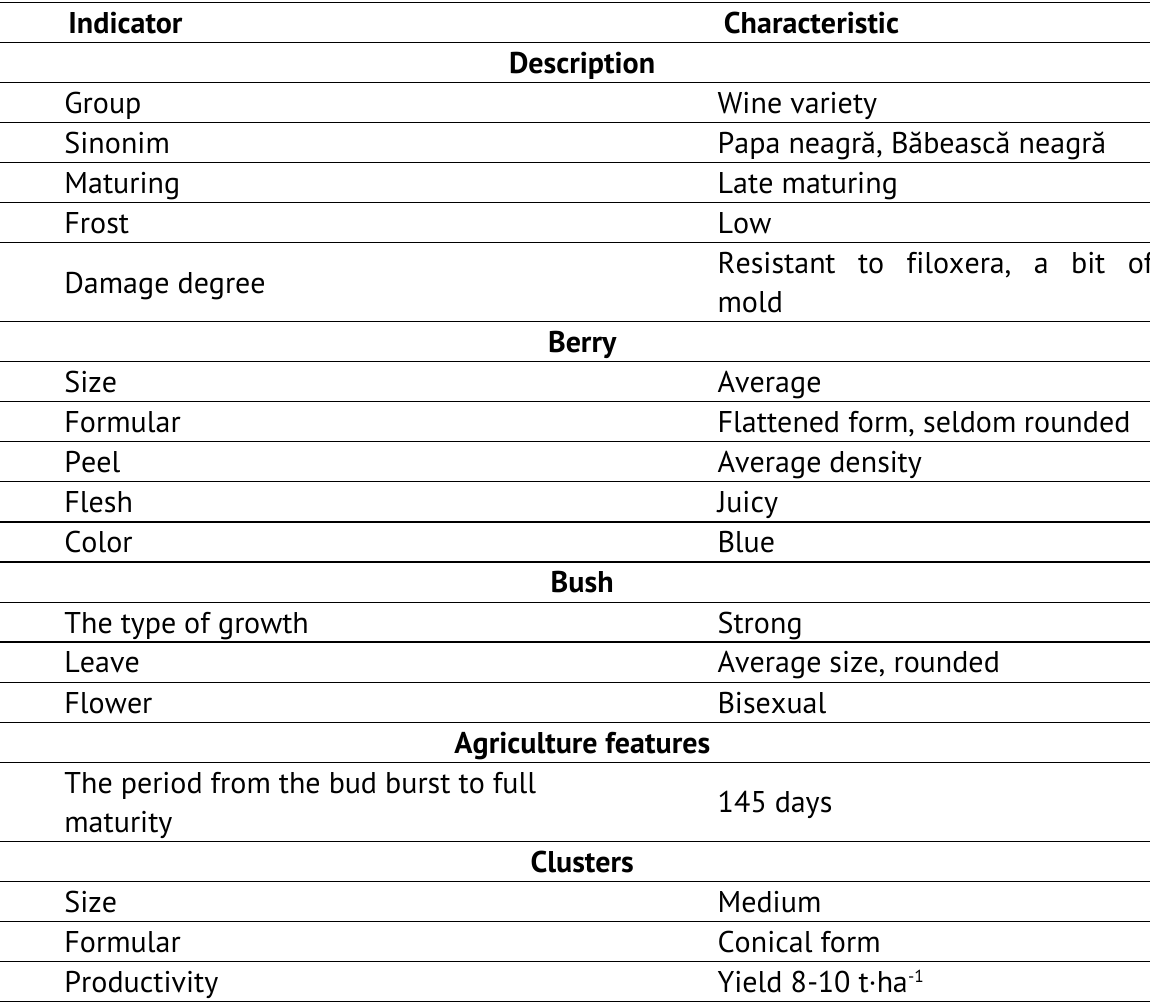
Rară Neagră grapes